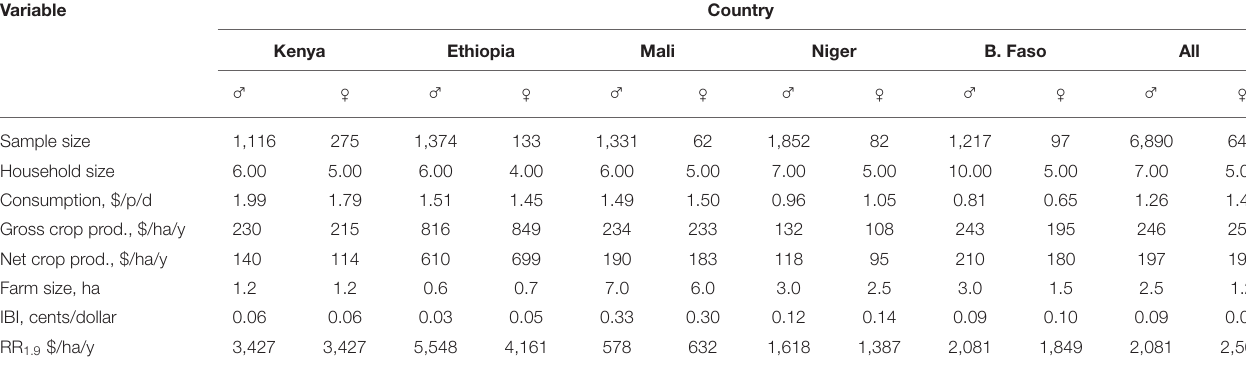
TABLE 6 | Median household characteristics and agricultural performance by country and by gender.